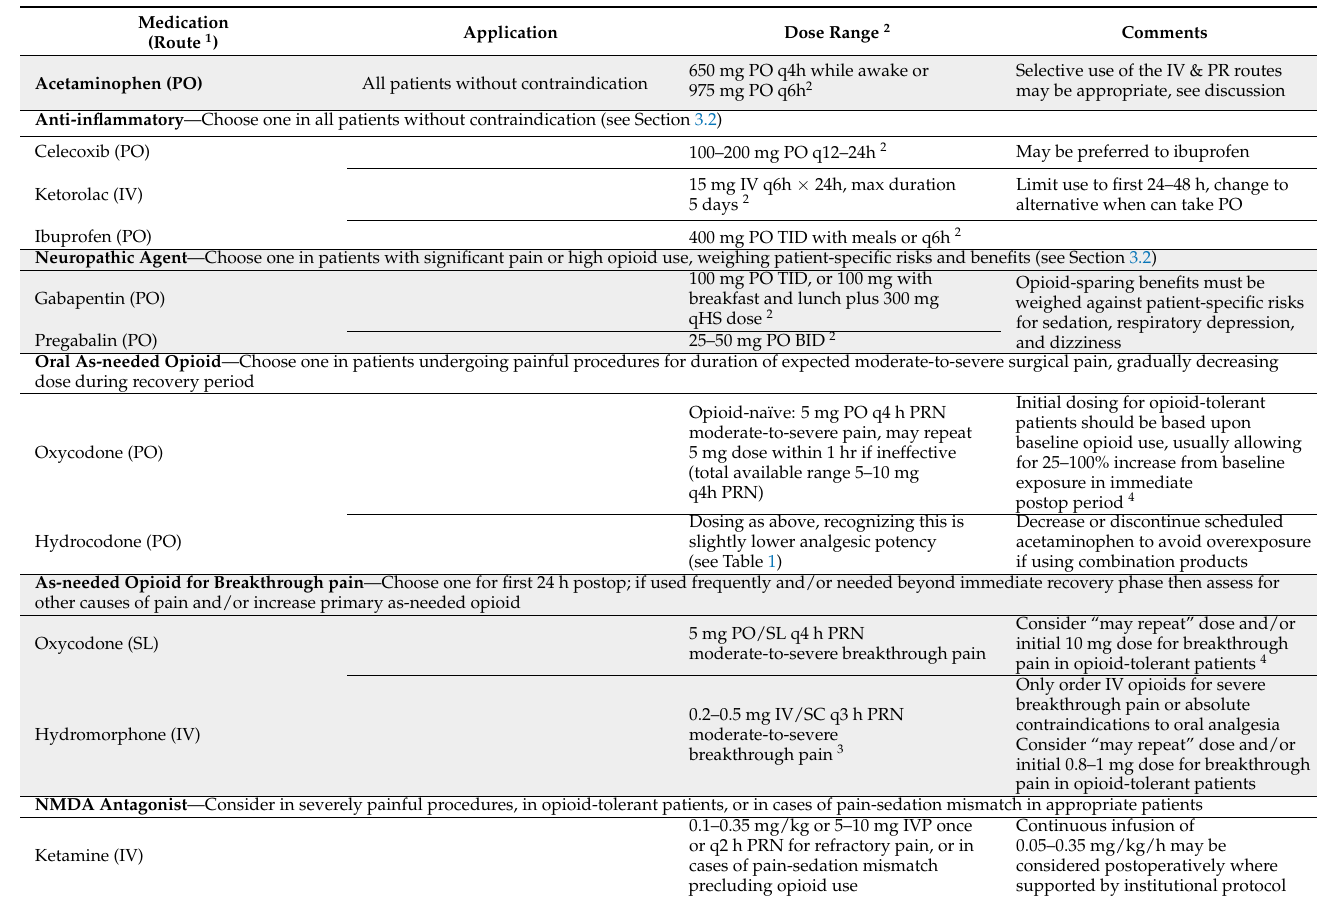
Table 8. Example of Postoperative Inpatient Pain Management